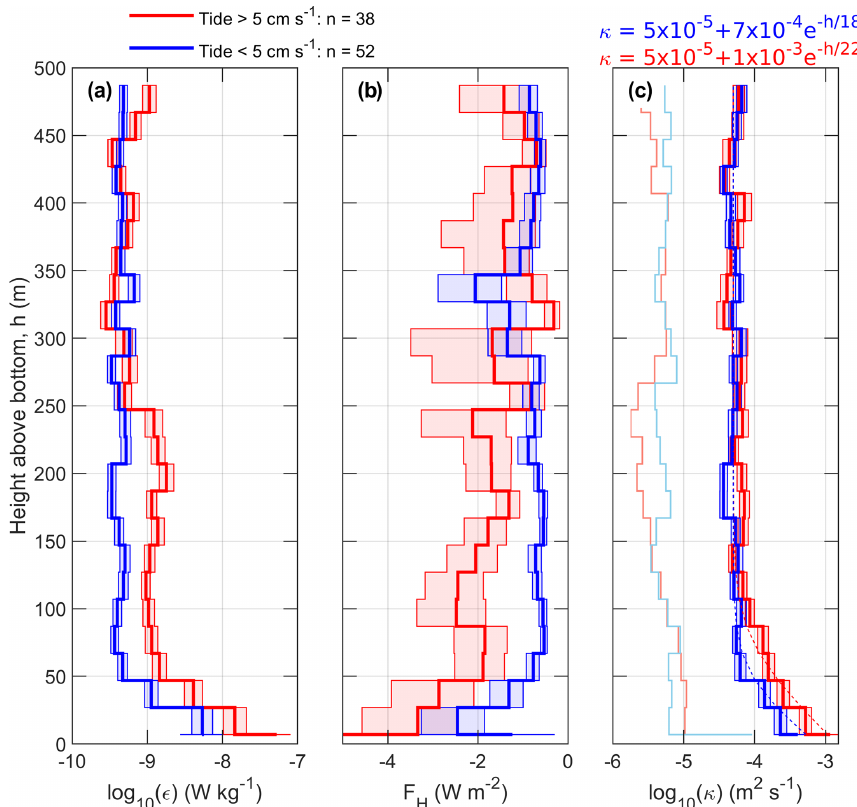
Figure 7. Average profiles of (a) dissipation rate (cid:15) , (b) turbulent heat flux F H and (c) diapycnal diffusivity κ for small (blue) and large (red) tidal current amplitudes estimated from Arc5km2018 at the time and location of each station. Average profiles are obtained as the maximum likelihood estimator from a lognormal distribution using the data points in 20m vertical bins. The vertical axis is height above bottom, relative to the seafloor depth from the echo sounder. n indicates the number of batch-averaged profiles for each tidal forcing category. Thin lines in (c) are the corresponding profiles for diffusivity at the lowest detection level (obtained by imposing a noise level for the dissipation rate of 1 × 10 − 10 Wkg − 1 ). The dashed lines are the curve fits using an exponential function. Resulting equations with the best-fit coefficients are shown above the panel. The shading is the 95% confidence envelope of the maximum